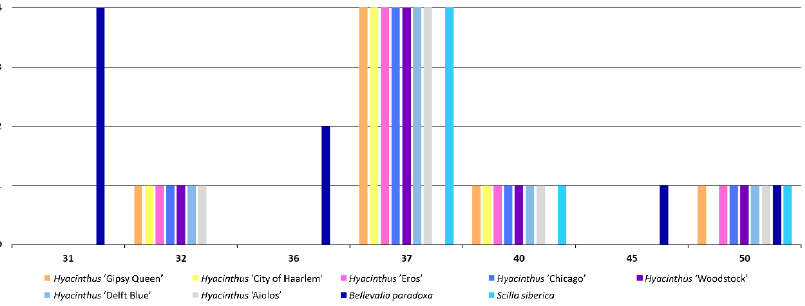
Figure 8. Frequency of LTRs of different lengths among the nine studied chloroplast genomes.